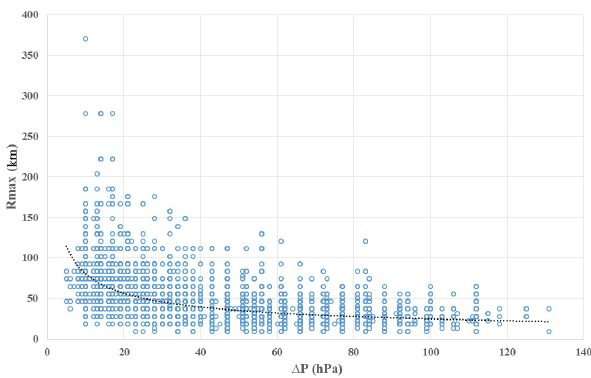
Figure 10. The relation between the central pressure differ- ence ( (cid:49)P ) and the radius of maximum wind ( R max